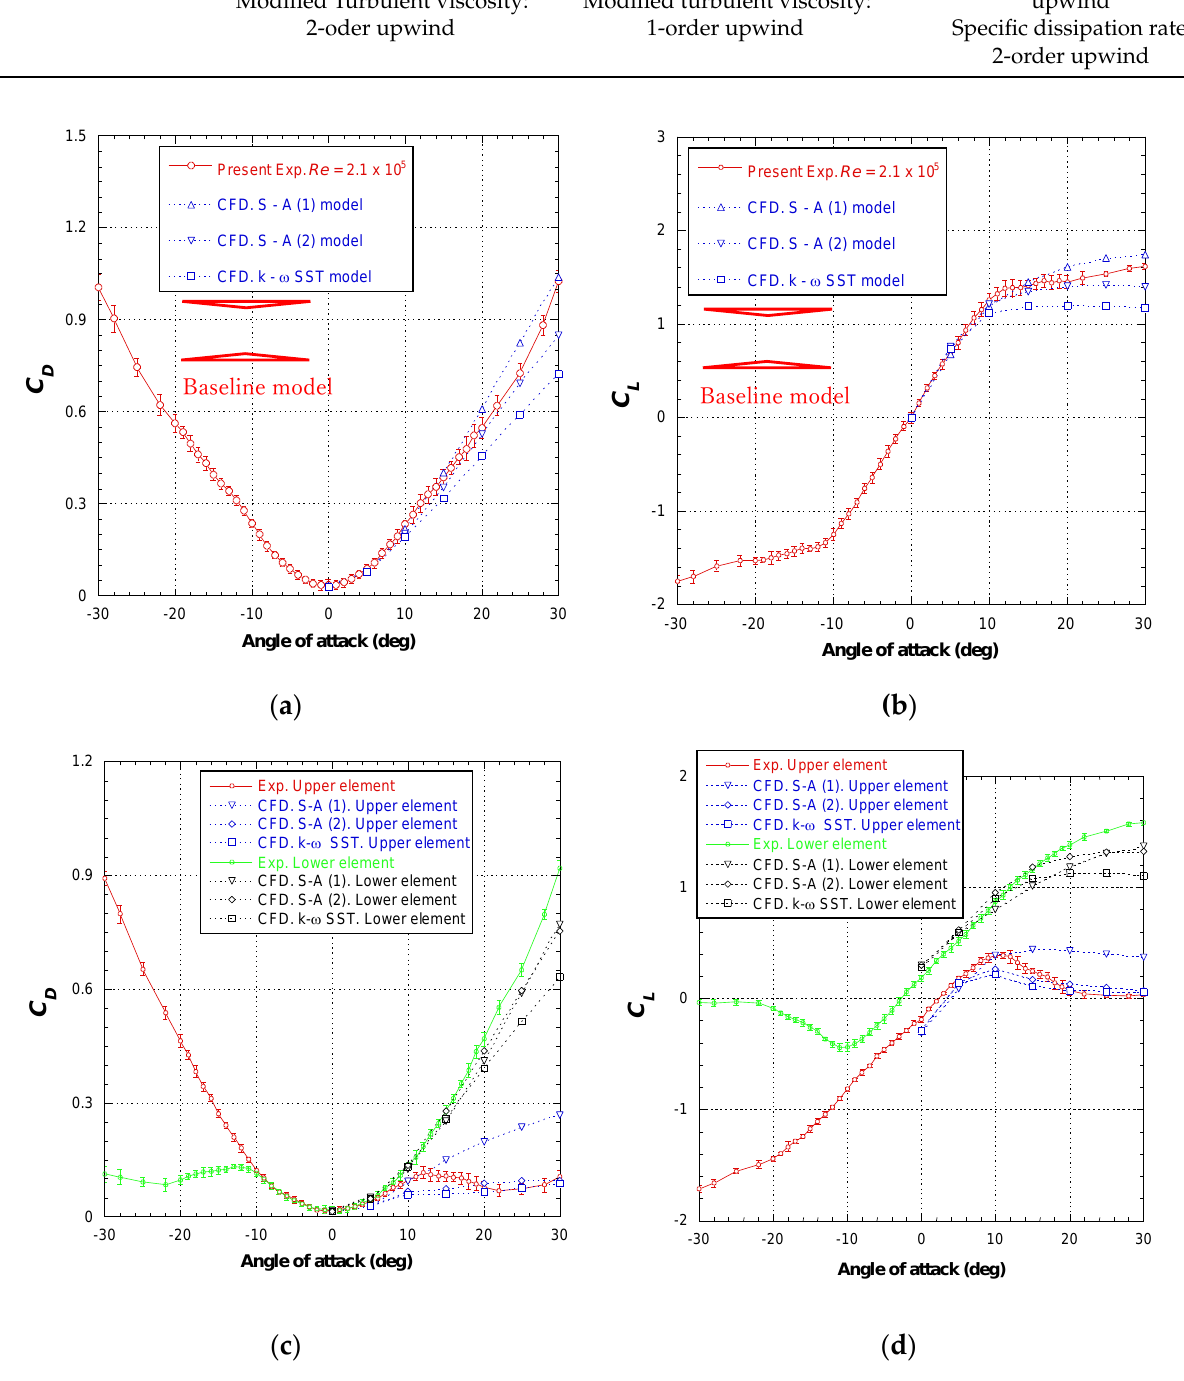
Figure A2. Investigations of turbulence model in numerical simulations, baseline configuration: ( a ) total drag coefficient; ( b ) total lift coefficient; ( c ) drag coefficient of upper and lower elements; ( d ) lift coefficient of upper and lower elements.